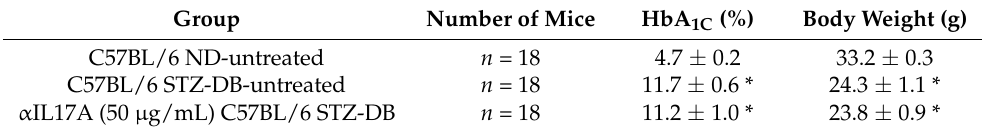
Figure 2. Acute Phase Cytokines in the Retinas of STZ-Diabetic Mice After anti-IL-17A Injection. Ella analysis of IL-1  ( A ), IL-6 ( B ), and TNF-  ( C ) in individual retinas (n = 9/group) of non-diabetic,